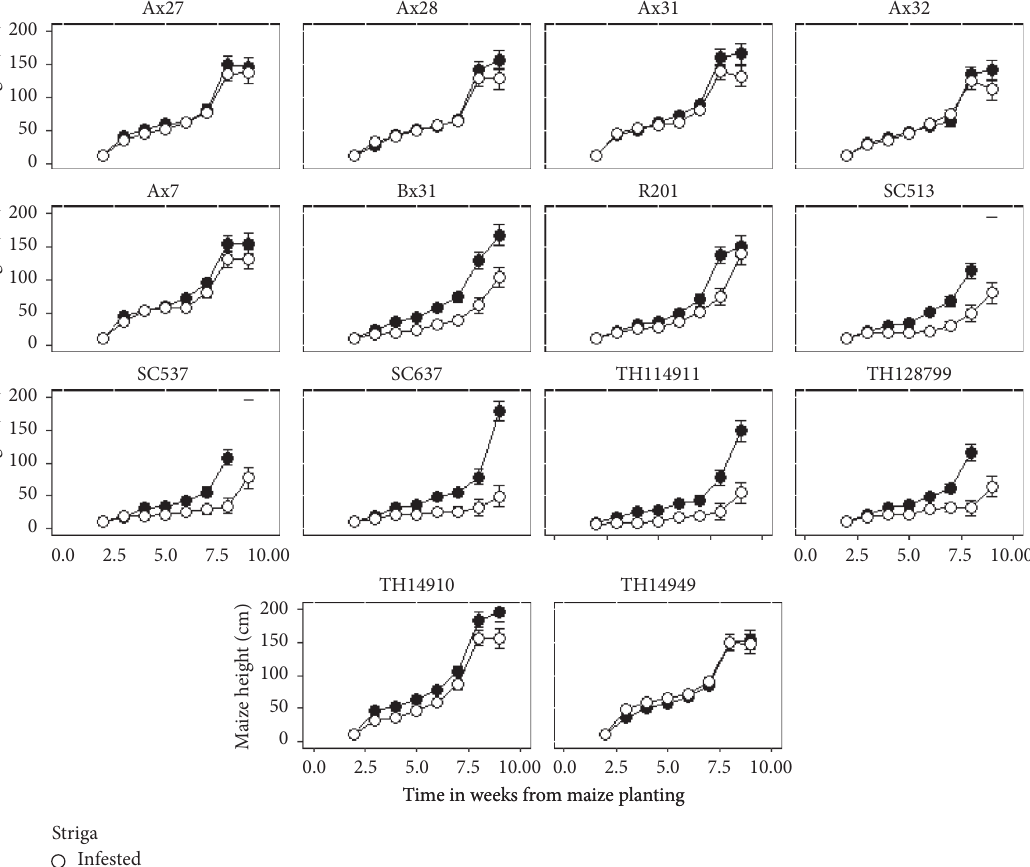
Figure 4: Maize plant heights recorded from 2 nd WACE up to 9 th WACE. Error bars indicate the standard errors shared between four